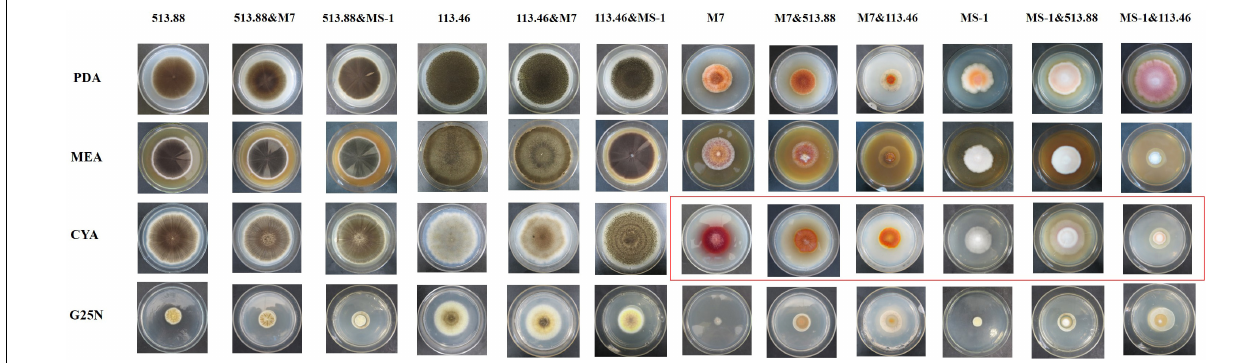
Frontiers in Microbiology |